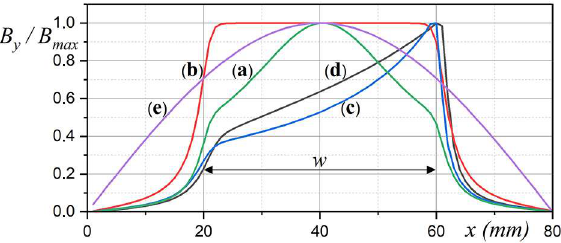
Figure 12. Magnetic field distribution over the non-symmetric magnetic pole of SM (normalized values). Comparison: sinusoidal air gap ( a ); constant air gap ( b ); linear air gap ( c ); optimized air gap ( d ); distribution given by Equation (19) ( e ).